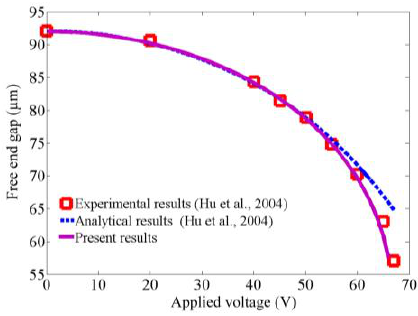
Figure 2. The vatiation of free end gap with the applied voltage.